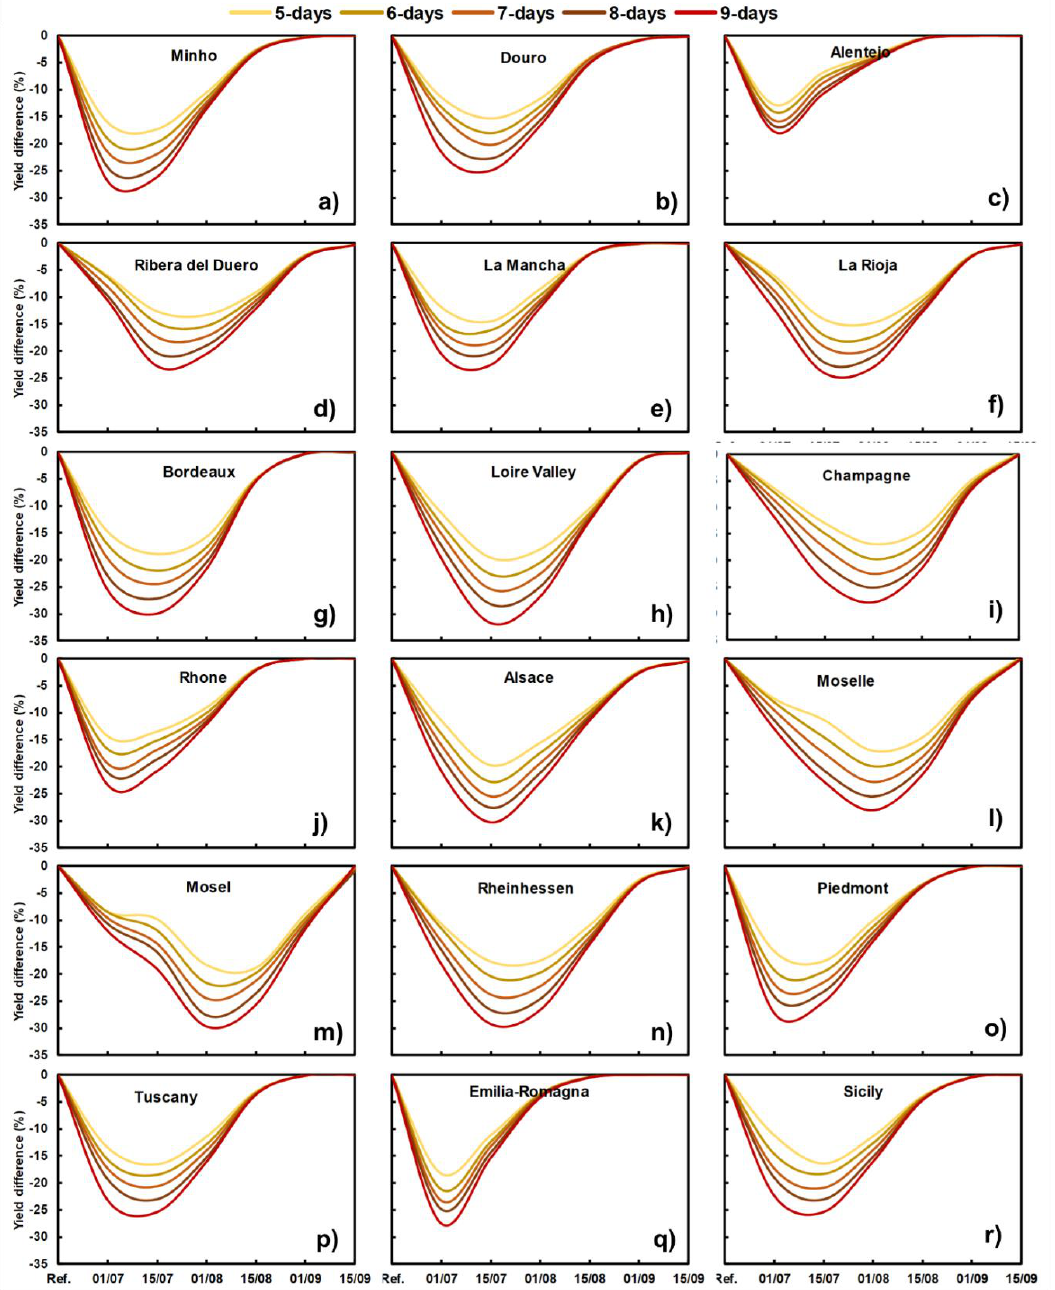
Figure 3. Yield relative difference (in %) between normal years and years with heatwaves, with a duration from five to nine days, in ( a ) Minho, ( b ) Douro, ( c ) Alentejo, ( d ) Ribera del Duero, ( e ) La Mancha, ( f ) La Rioja, ( g ) Bordeaux, ( h ) Loire Valley, ( i ) Champagne, ( j ) Rhone, ( k ) Alsace, ( l ) Moselle, ( m ) Mosel, ( n ) Rheinhessen, ( o ) Piedmont, ( p ) Tuscany, ( q ) Emilia-Romagna and ( r ) Sicily, depending on to the date of onset of the heatwave.